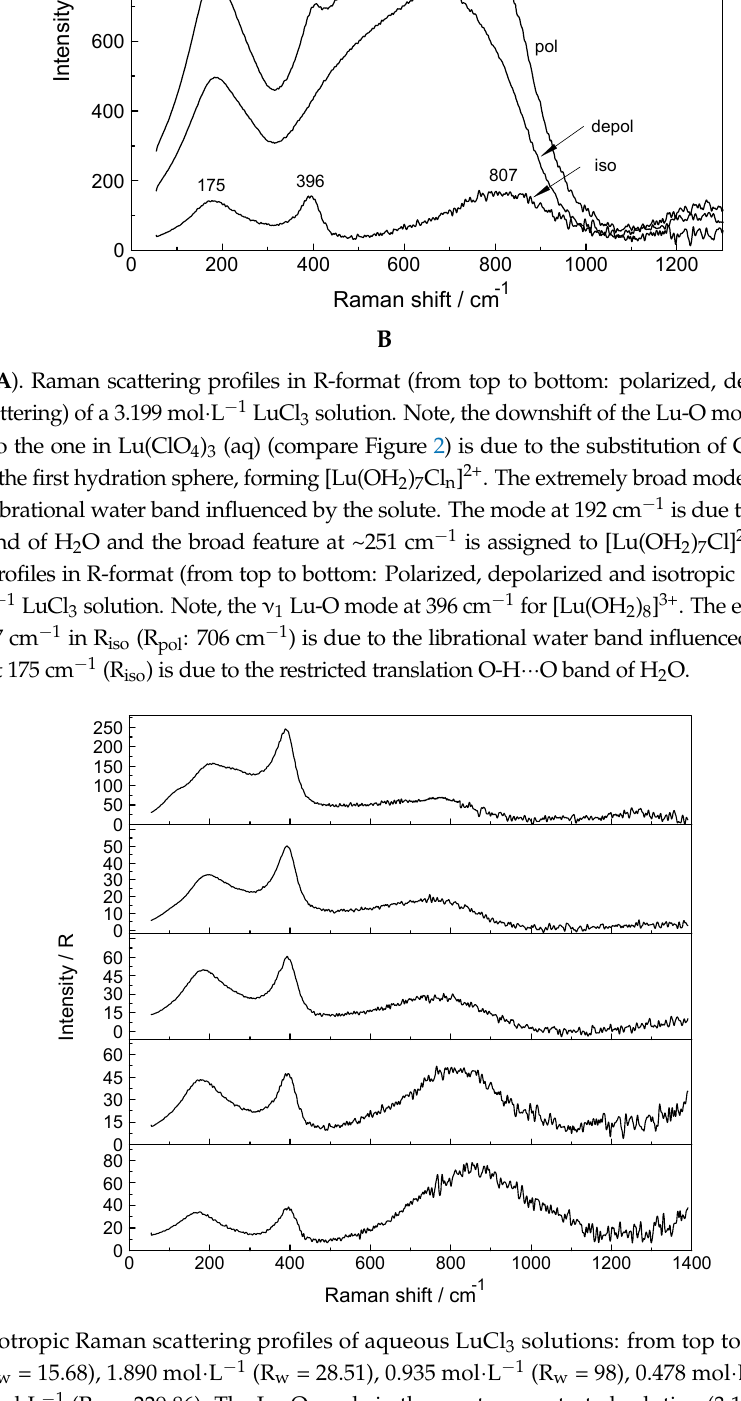
Figure 6. Fraction of species detected by quantitative Raman spectroscopy. The filled circles denote the [Lu(OH 2 ) 8 ] 3+ , the fully hydrated Lu 3+ and the filled squares the 1:1 chloro-complex species. The logK 1 ′ value measured by Raman spectroscopy is − 0.62 (I = 5.61 mol·L − 1 ) and reveals the weak nature of the chloro-complex in LuCl 3 (aq) at 23 °C. Literature values for logK 1 for rare earth